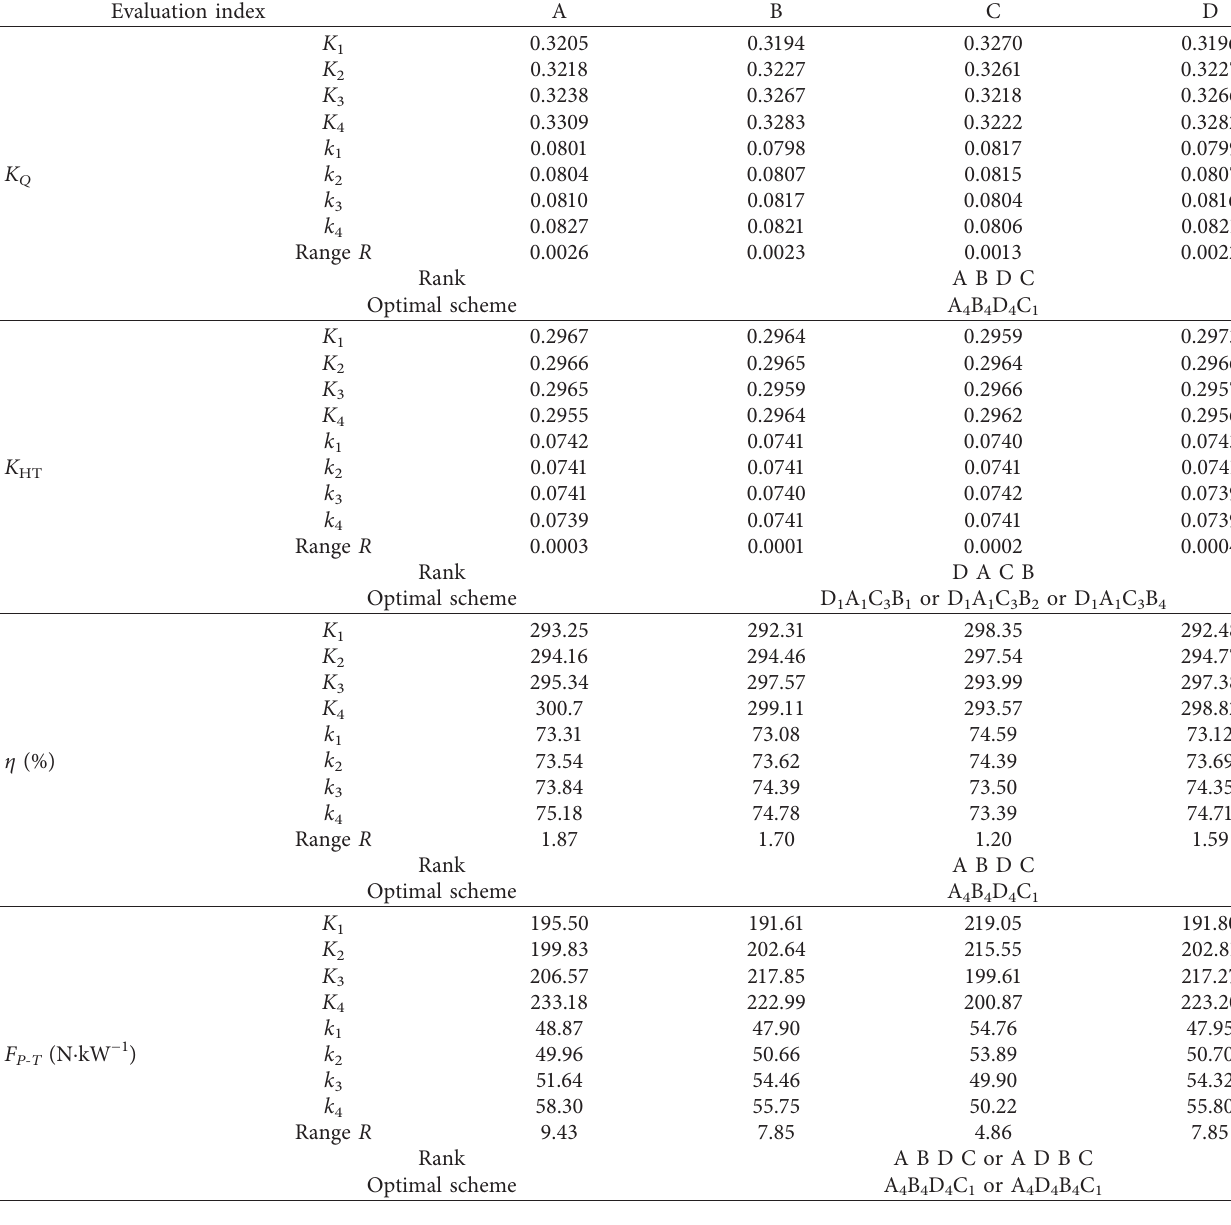
Table 4: Results